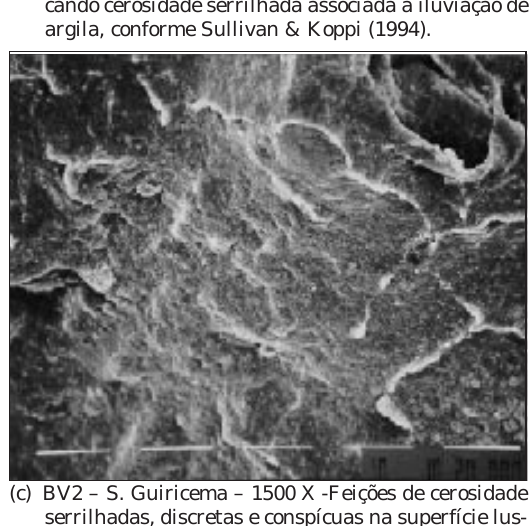
Figura 4. Fotomicrografias em microscópio eletrôni- co de varredura, ilustrando feições de recobri- mento argilosos na superfície de agregados em blocos dos solos TR (a), PE1 (b) e BV2